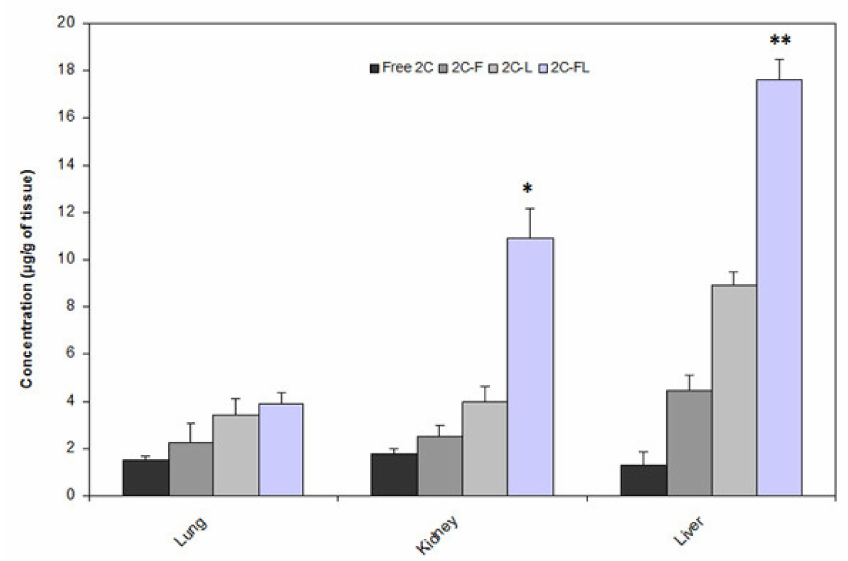
Figure 3. Biodistribution profile of 2C from fibrin beads, liposomes, and fibrin liposomes. Distribution of 2C after 12 h of intraperitoneal administration of free 2C, 2C-F, 2C-L, and 2C-FL. Data are presented as the mean ± SD of three independent experiments. Free 2C versus 2C-F, 2C-L, or 2C-FL; * p < 0.05; ** p <